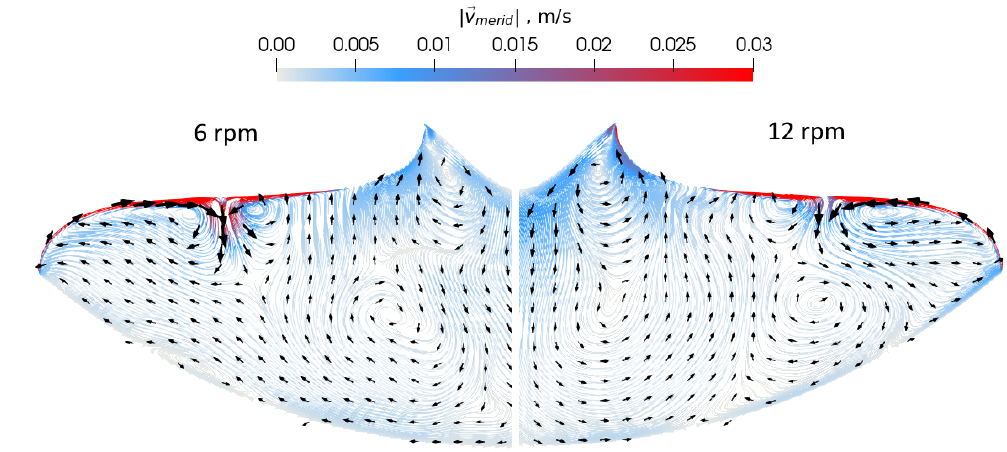
Figure 17. The time-averaged melt velocity in the vertical cross-section of the melt, simulated for the cylindrical phase with D C = 102mm and crystal rotation rates of 6 rpm ( left ) and 12 rpm ( right